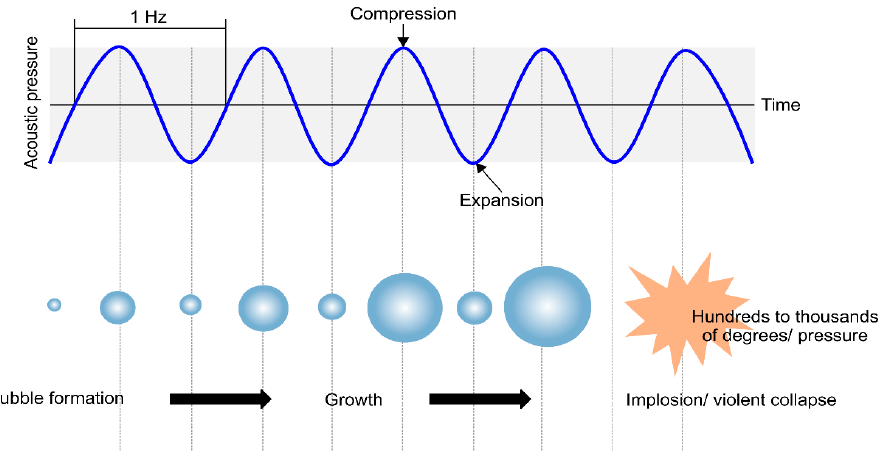
Figure 5. Process of cavitation generation and collapse via ultrasound.